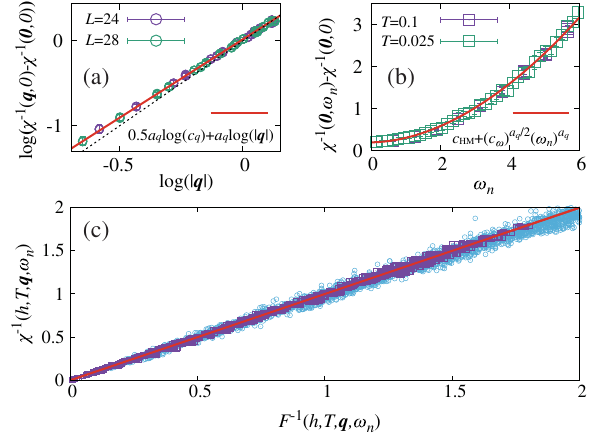
FIG. 3. (a) Inverse spin susceptibility at ω n ¼ 0 as a function of j q j (data points with L ¼ 24 , 28 and T ¼ 0 . 125 ). The red line shows the fitting with χ − 1 ¼ c q q a q , and we get a q ¼ 1 . 85 ð 3 Þ . The black dashed line shows the slope a q ¼ 2 . (b) Inverse spin susceptibility at q ¼ 0 as a function of ω n (data points with L ¼ 20 , 24, and 28 for T ¼ 0 . 1 , with L ¼ 20 for T ¼ 0 . 025 ). The c ω a ω n . (c) Data red curve shows the fitting with χ − 1 ¼ c ω HM þ collapse for Ising susceptibility against the functional Eq. (10), where F − 1 ¼ c t T a t þ c h j h − h c j γ þð c q q 2 þ c ω ω 2 Þ a q = 2 þ Δ ð q ; ω n Þ . The dark violet squares (3946 in total, made up of T ¼ 1 . 0 , 0.83, 0.67, 0.5, 0.4, 0.3, 0.25, 0.2, 0.17, 0.13, 0.1; h ¼ 3 . 27 ,3.3,3.4,3.5,3.6,3.7,3.8,3.9,4.0; and L ¼ 24 ) are for data with zero frequency, while the light blue circles (6096 in total, made up of L ¼ 20 with T ¼ 0 . 1 , 0.05, 0.033, 0.025, 0.014, 0.01, and L ¼ 24 , 28 with T ¼ 0 . 1 , 0.05) are for data with frequency dependence. The red line with y ¼ x serves as the baseline for comparison of QMC data with the functional